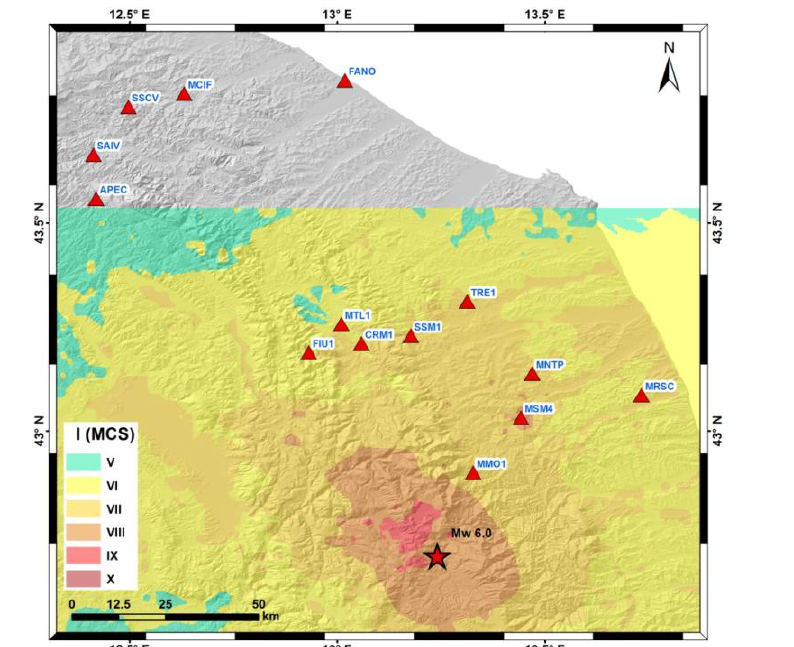
Figure 1 . Map of the stations at the base of the strategic buildings (red triangles). Epicenter of 24 August 2016 (red star). MCS Intensity map modified by ShakeMap available online (http://shakemap.rm.ingv.it). The ShakeMap available does not cover the northern part of Marche